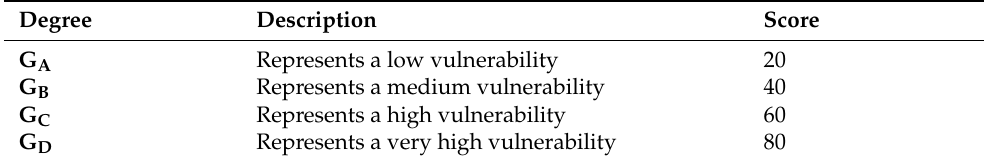
Table 2. Degrees of vulnerability